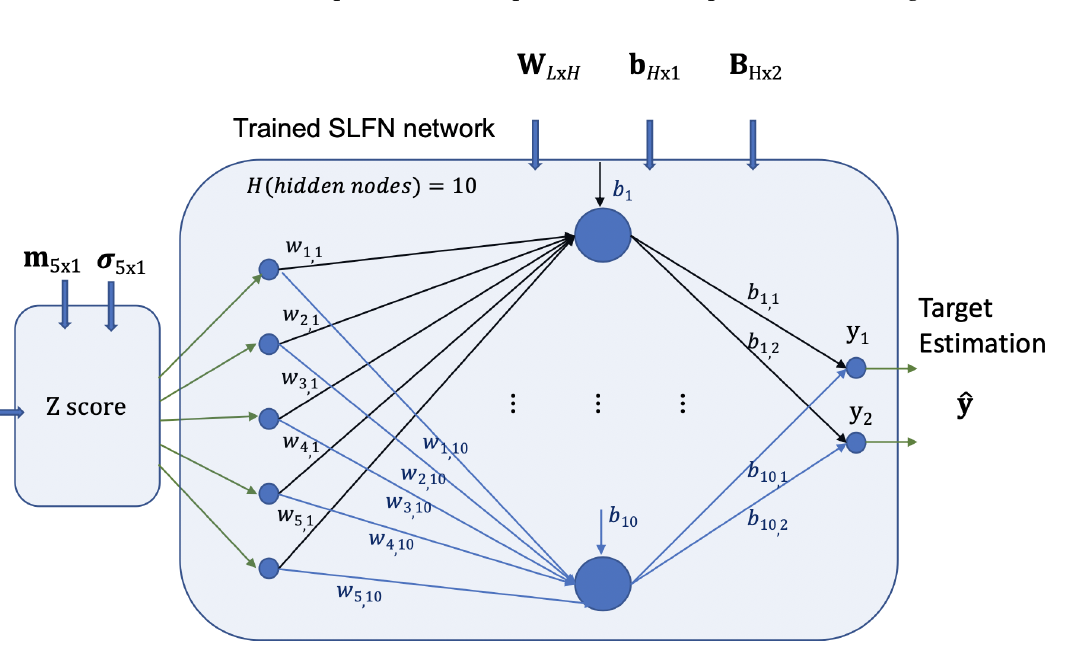
Figure 1. Detail of the structure of the SLFN in terms of the parameters that define it ( W , b and B ), the vector of input features ( x ), the z-score normalisation process and the output vector (ˆ y